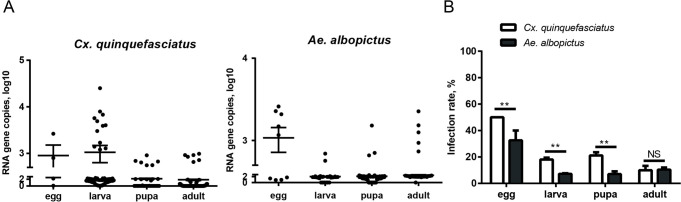
Viral load of YCV in different life stages of the F1 generation.After the infected Cx. quinquefasciatus and Ae. albopictus parent females had oviposited, egg papers were hatched in deoxygenated water. (A) Offspring were reared and YCV RNA copies were detected by qRT-PCR in different life stages (egg, larva, pupa and adult). One dot represents one mosquito. The results are expressed as the mean ± SEM. (B) Positive rate. The results are expressed as the mean ± SEM. The results were analyzed using the unpaired t-test. A P value of < 0.05 indicates statistical significance. P < 0.05, *; P < 0.001, ** and P < 0.001, ***.